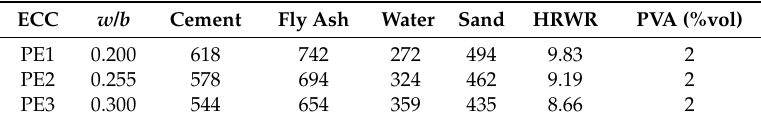
Table 3. Mix proportions of ECC composites (kg/m 3 ).